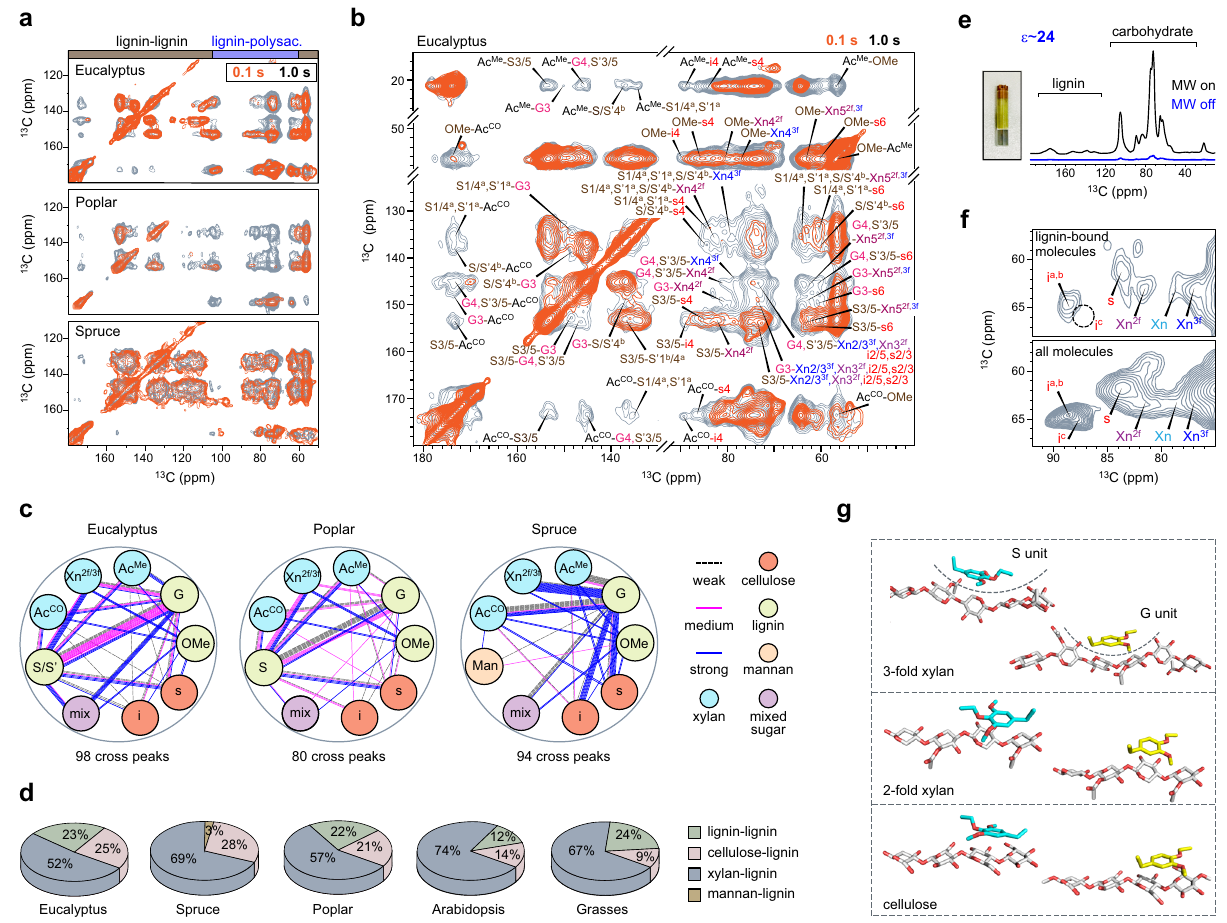
Fig. 3 DNP-assisted detection of long-range interactions de fi nes lignin – carbohydrate packing. a Overlay of long-range (1.0 s mixing; grey) and short- range (0.1 s mixing; orange) 2D 13 C- 13 C correlation spectra. The long- and short-range spectra showed similar spectral patterns in spruce: softwood polymers are homogeneously mixed on the molecular level. b Dipolar-gated 2D 13 C- 13 C correlation spectra showing 98 intermolecular cross peaks in eucalyptus. c Summary of 272 intermolecular interactions identi fi ed in eucalyptus, poplar, and spruce. Cellulose, lignin, mannan, and mixed sugars are color-coded in red orange, light green, light orange, and purplre, respectively. Source data are provided as a Source Data fi le. d The count of lignin – lignin, cellulose – lignin, and xylan – lignin interactions in eucalyptus, poplar, spruce, Arabidopsis , and grasses (maize, rice, and switchgrass). Lignin – cellulose interactions are scarce in Arabidopsis and grasses but become abundant in woods. Source data are provided as a Source Data fi le. e DNP enhancing NMR sensitivity of eucalyptus by 24-fold. Inset shows a picture of the plant material in a sapphire DNP-NMR rotor. f Comparison of the equilibrium spectrum (bottom) of eucalyptus that detects all components with the aromatic-edited spectrum (top) that only shows lignin-bound molecules. The lignin-bound polysaccharides include the two-fold, three-fold, and mixed conformers of xylan as well as the surface and interior cellulose. The deeply embedded glucan chains in cellulose (i c ) are absent as highlighted using the dash line circle. g DFT energy-minimized structures showing the possible packing between lignin units and